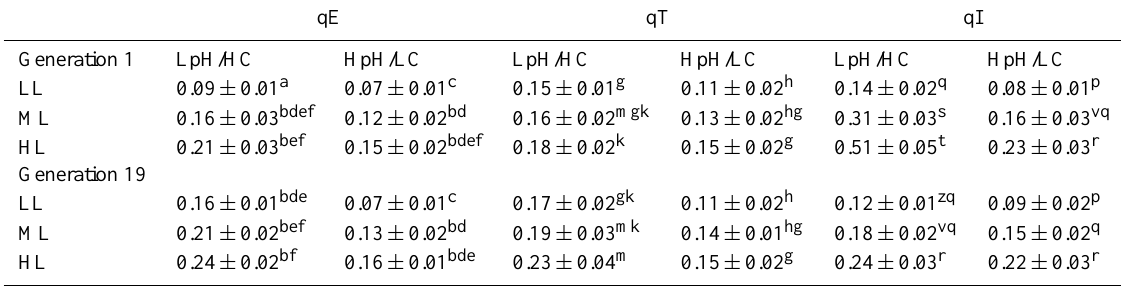
Table 2. The energy-dependent (qE), state transition (qT) and photoinhibition quenching (qI) of P. globosa at generation 1 and generation 19, grown in pH 7.70 culture under different irradiance levels (LL, 25; ML, 200; HL, 800µmol photonsm − 2 s − 1 ). HC and LC represent high and low CO 2 , respectively. Superscripts with different letters indicate significant differences between groups. The data represent the mean ± SD ( n = 3, triplicate cultures).